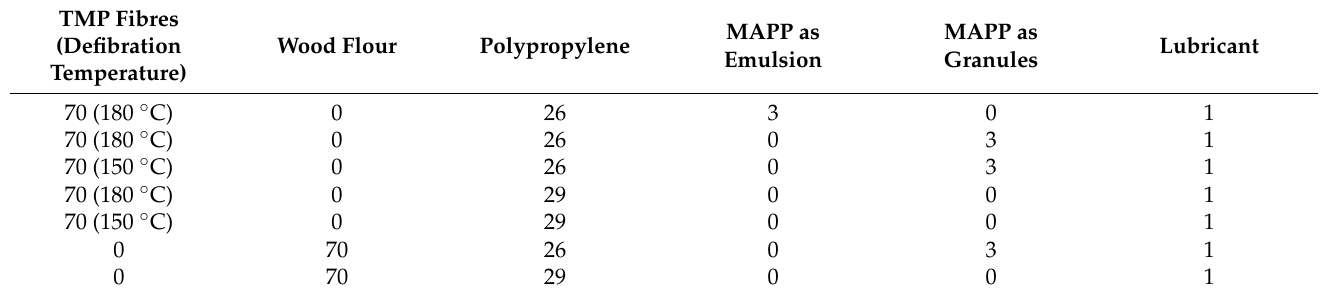
Table 1. Wood-plastic composites (WPC) formulations. Percentages represent